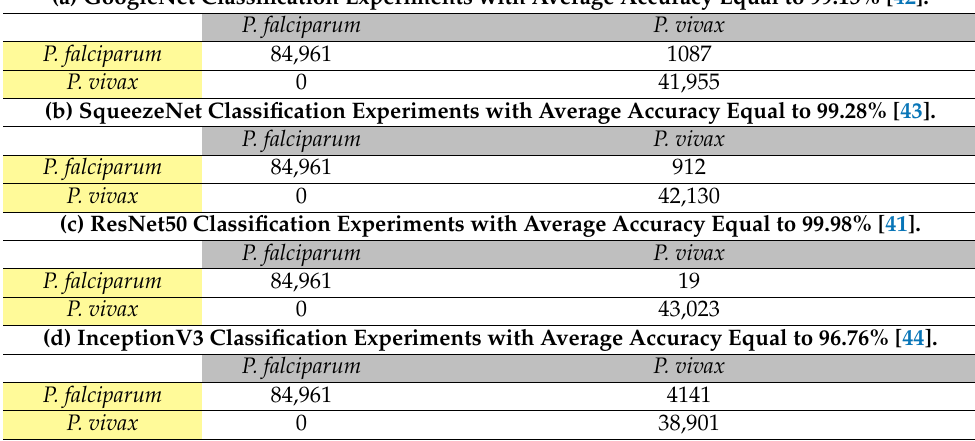
Figure 5. Training and testing statistics for all CNN networks described in Section “Experimental network settings” that classify patches as either P. falciparum or P. vivax with five-fold cross-validation on patient-level. Subfigure ( a ) shows the statistics for the training data, subfigure ( b ) shows the actual data that has been used for training after balancing the number of P. falciparum and P.vivax parasites in each fold, and subfigure ( c ) shows the statistics for the testing data. Table 4. Confusion matrices for patch-based two-class classification, P. falciparum vs. P. vivax , using different networks. Each matrix is the summation of five-fold cross-validation on patient-level. Gray represents target values, whereas yellow represents predicted values. The reported accuracy, written in each table’s caption, is the ratio of the sum of diagonal values over the total number of samples. (a) GoogleNet Classification Experiments with Average Accuracy Equal to 99.15%